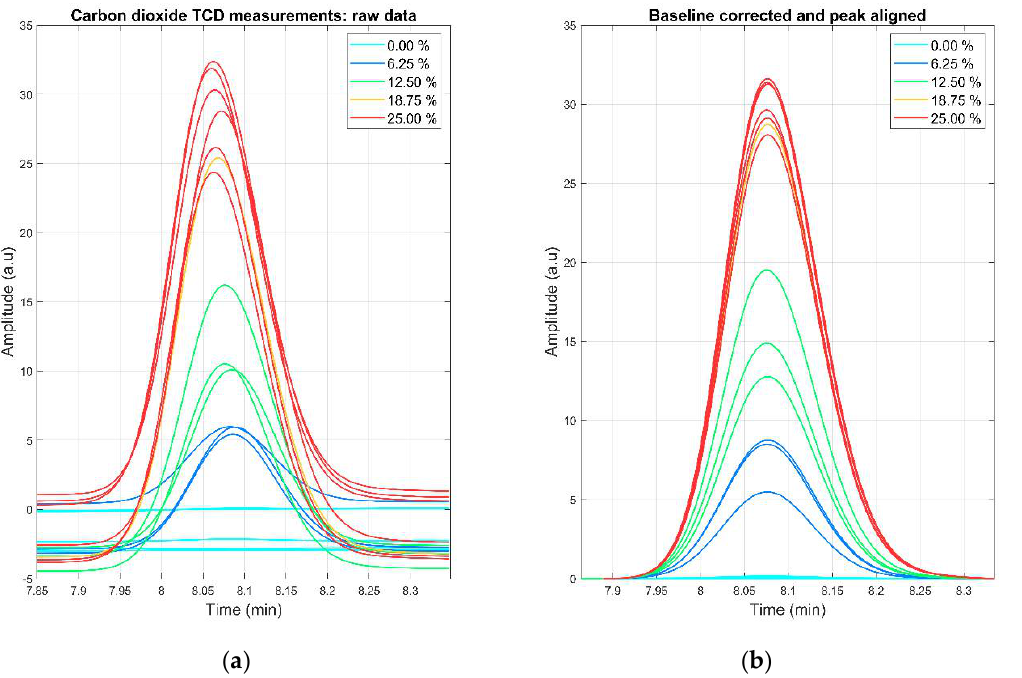
Figure 2. ( a ) Raw carbon dioxide TCD measurements. A misalignment of the peaks and different baseline levels can be observed; ( b ) carbon dioxide TCD measurements after baseline correction and peak alignment.